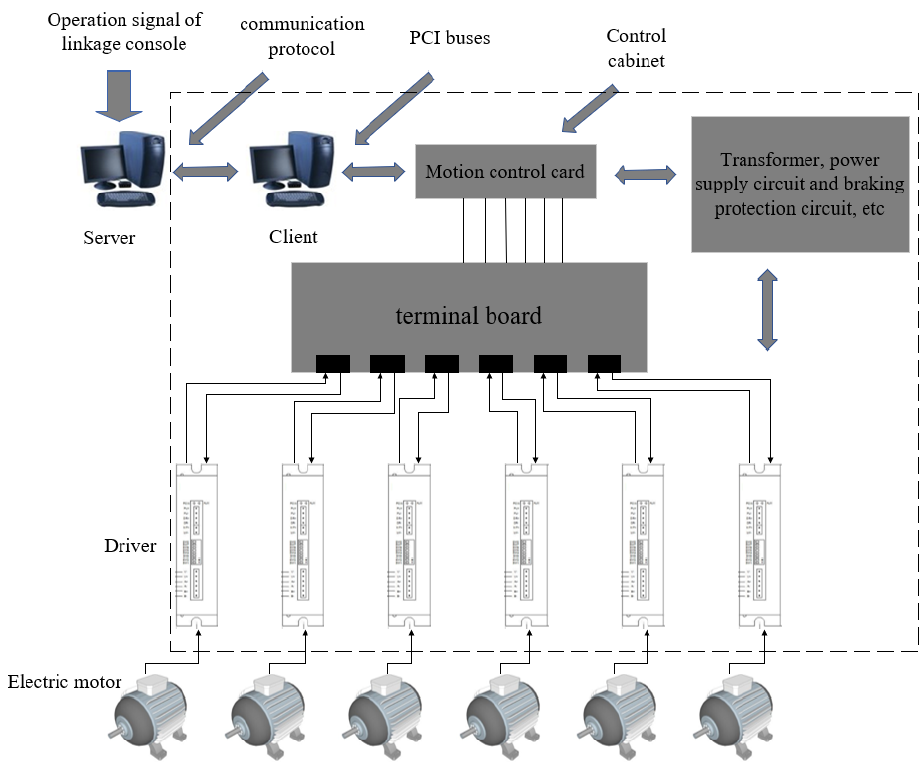
Figure 13. Hardware composition of the 6-DOF motion control system.